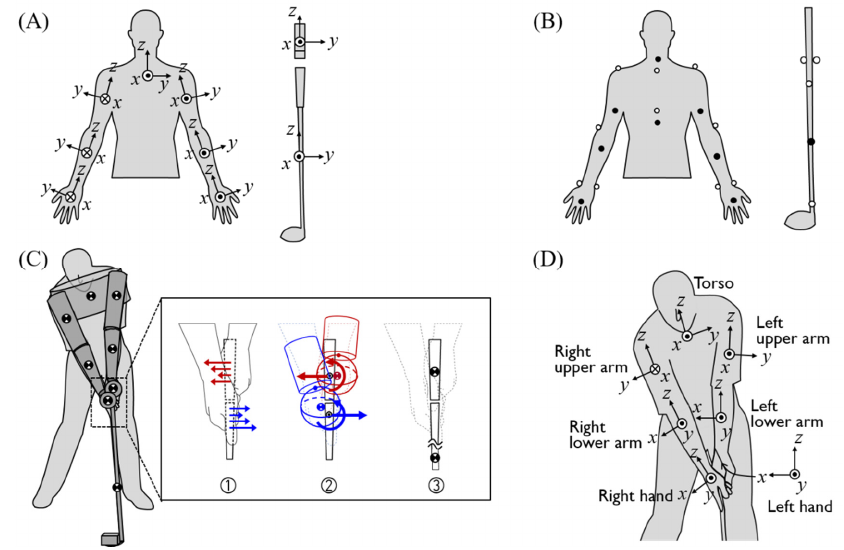
Figure 1. Sensor-embedded club. ( A ) Size of the sensor. ( B ) Drawing of the grip part. ( C ) Picture of the developed sensor-embedded club. The dotted line represents the size of a typical driver grip. ( D ) Picture of the hands and grip when the club is held.